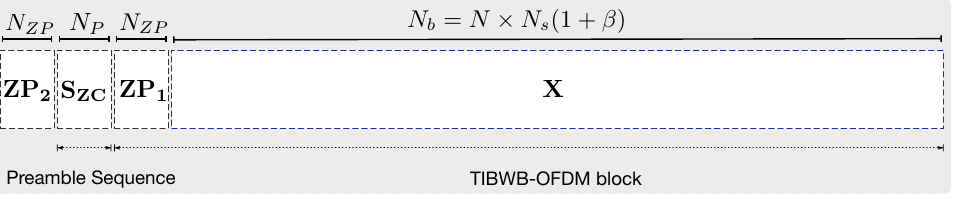
Figure 1. Adopted TIBWB–OFDM block frame